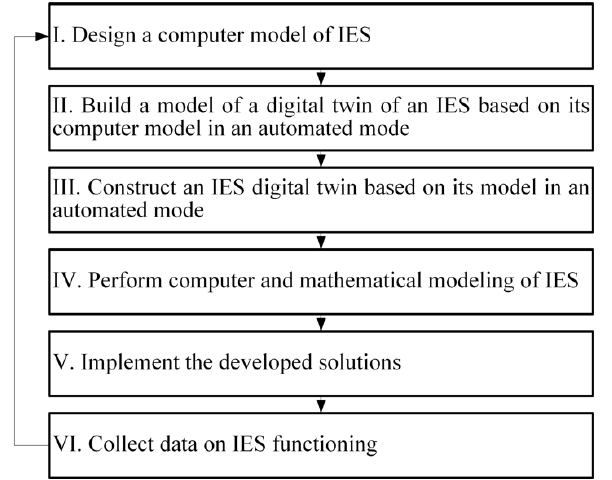
Figure 3. Diagram of the algorithm for solving the problem of IES design based on its digital twin.